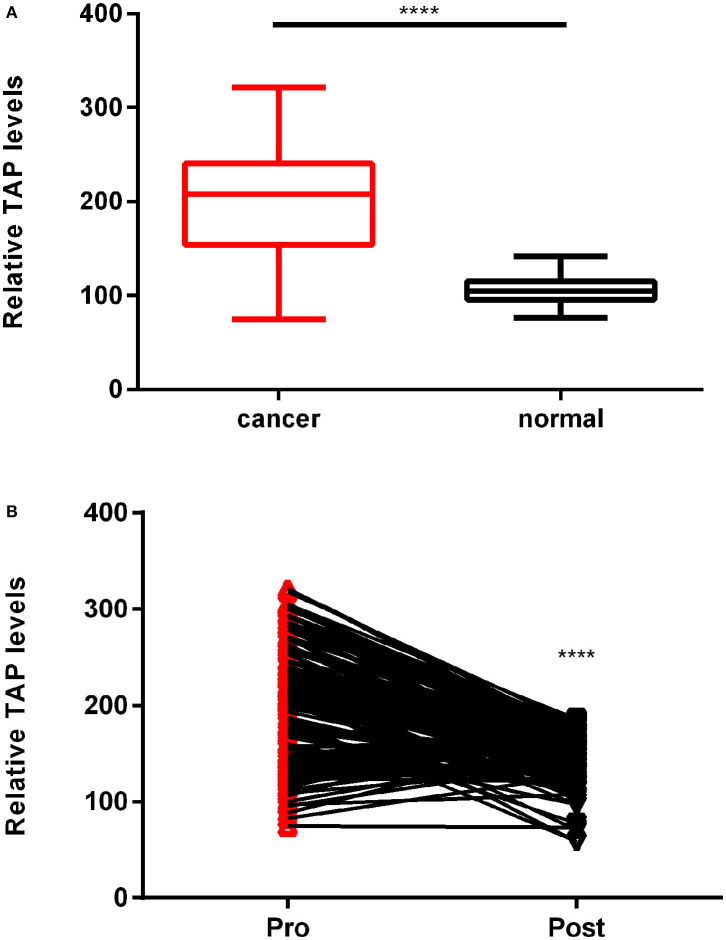
TAP relative expression in esophageal squamous cell carcinoma (ESCC) patients and cases who had normal physical checkup. (A) The TAP detection reagent was employed to measure the TAP expression in 183 ESCC and healthy blood samples. (B) A line links the pre-operation point to the post-operation point with a downward trend, demonstrating TAP downregulation in ESCC patients following surgery (****p < 0.0001).